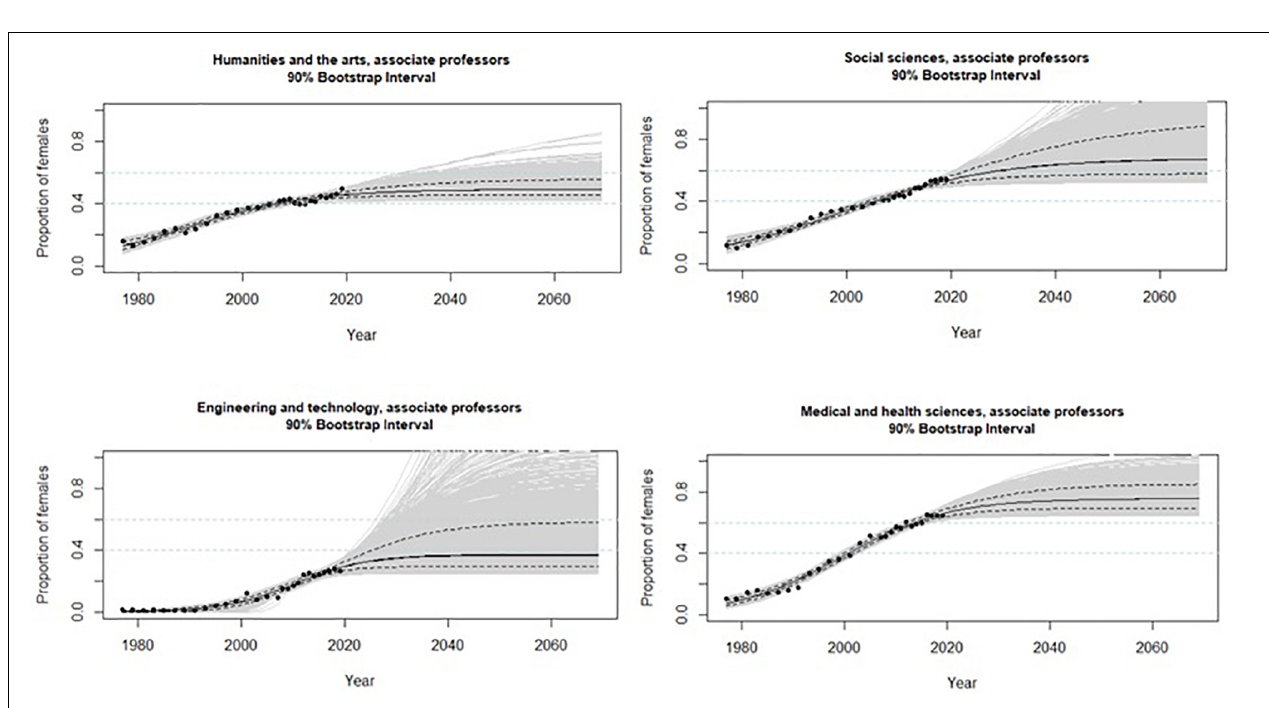
FIGURE 6 | Fit of data to a three-parameter logistic model for associate professors displayed as a thin black line. Fit of data for each of the 10,000 resampled time series are displayed in light gray lines, while the median (solid black line very similar to the point estimate) and 90% quantiles (dotted lines) are also displayed (see Figure 4 for